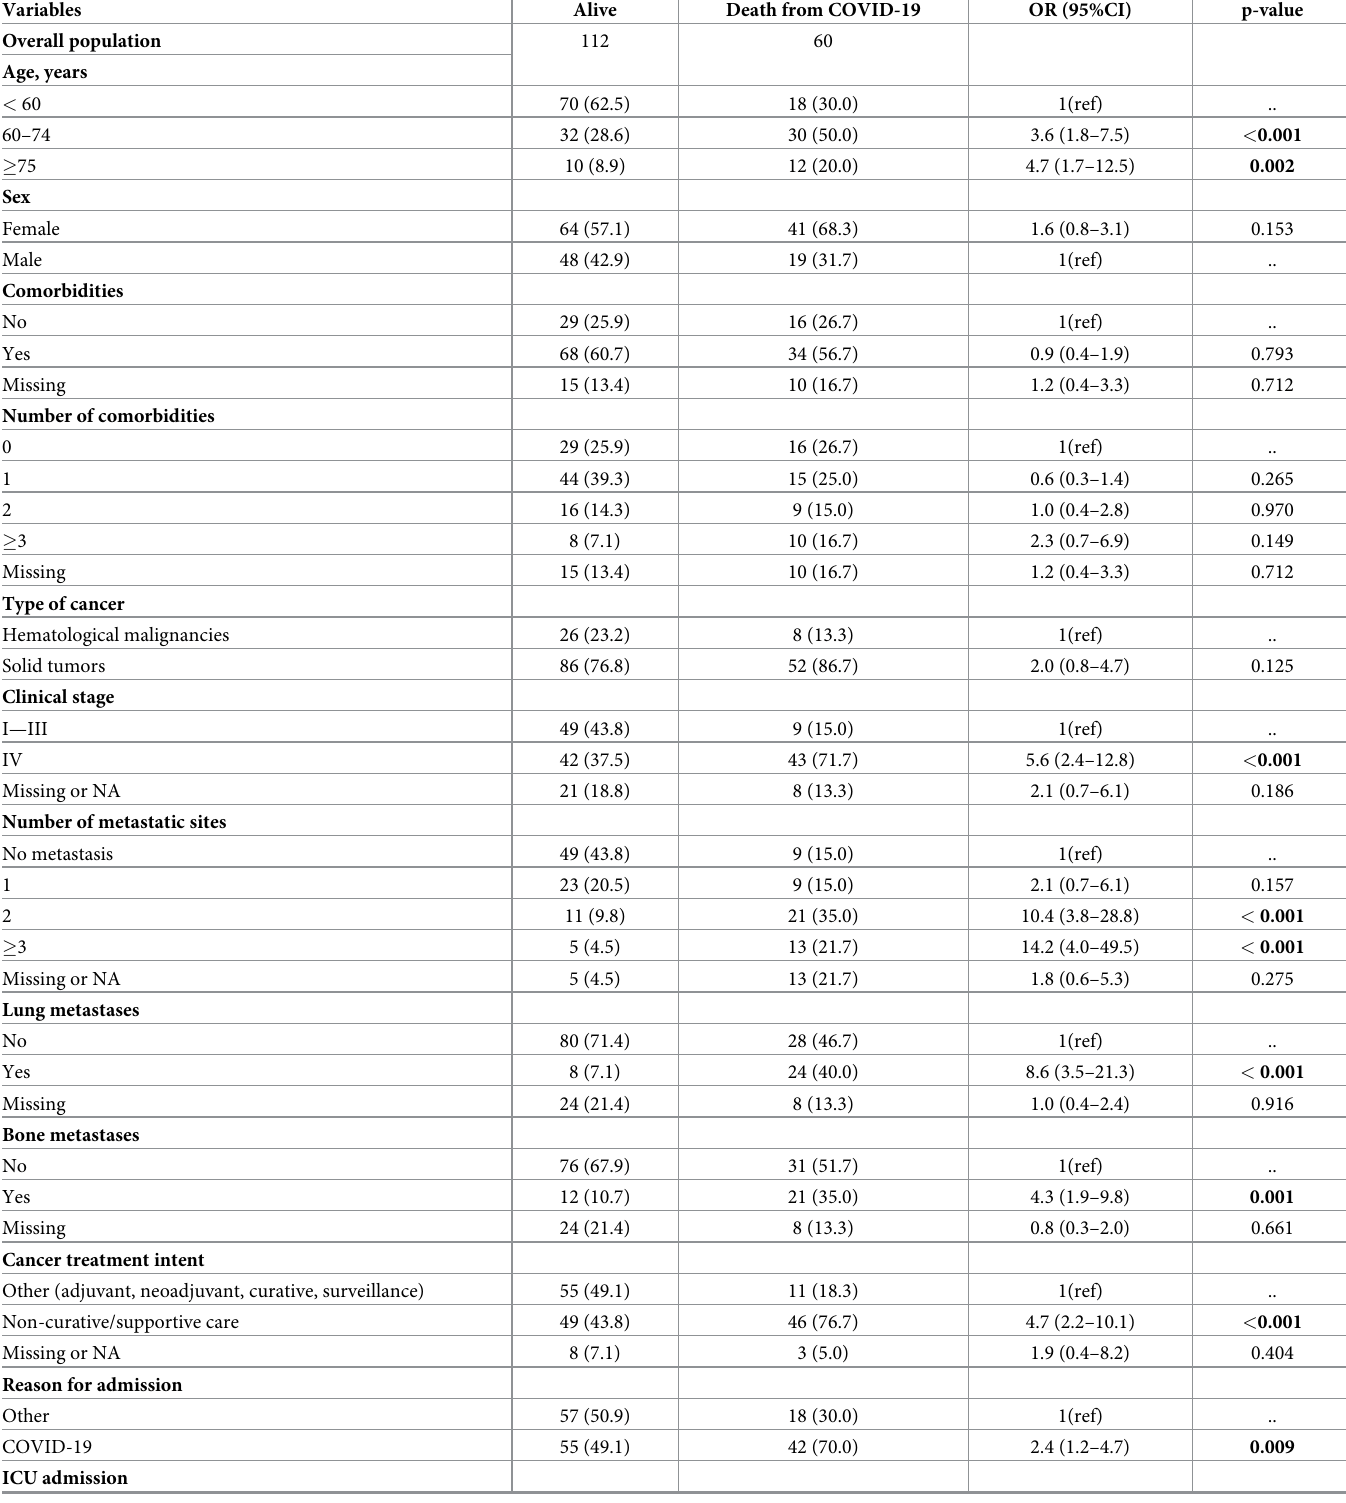
Table 3. Variables associated to the risk of death from COVID-19 �